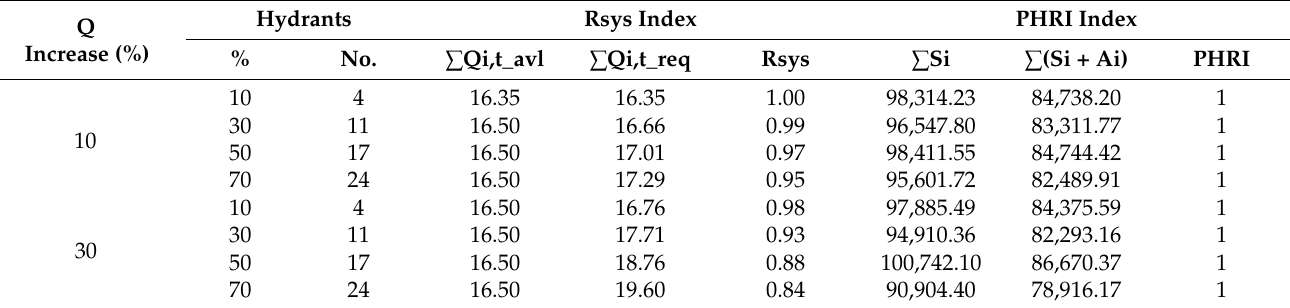
Table 7. Rsys” and “PHRI” results, for scenario 2 in shifts.